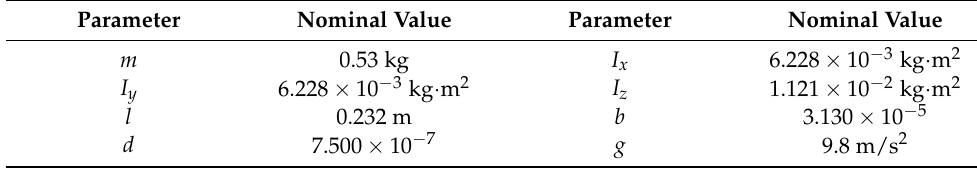
Figure 1. The schematic of the quadrotor UAV system. Table 1. Nominal values for the parameters of an uncertain quadrotor UAV.